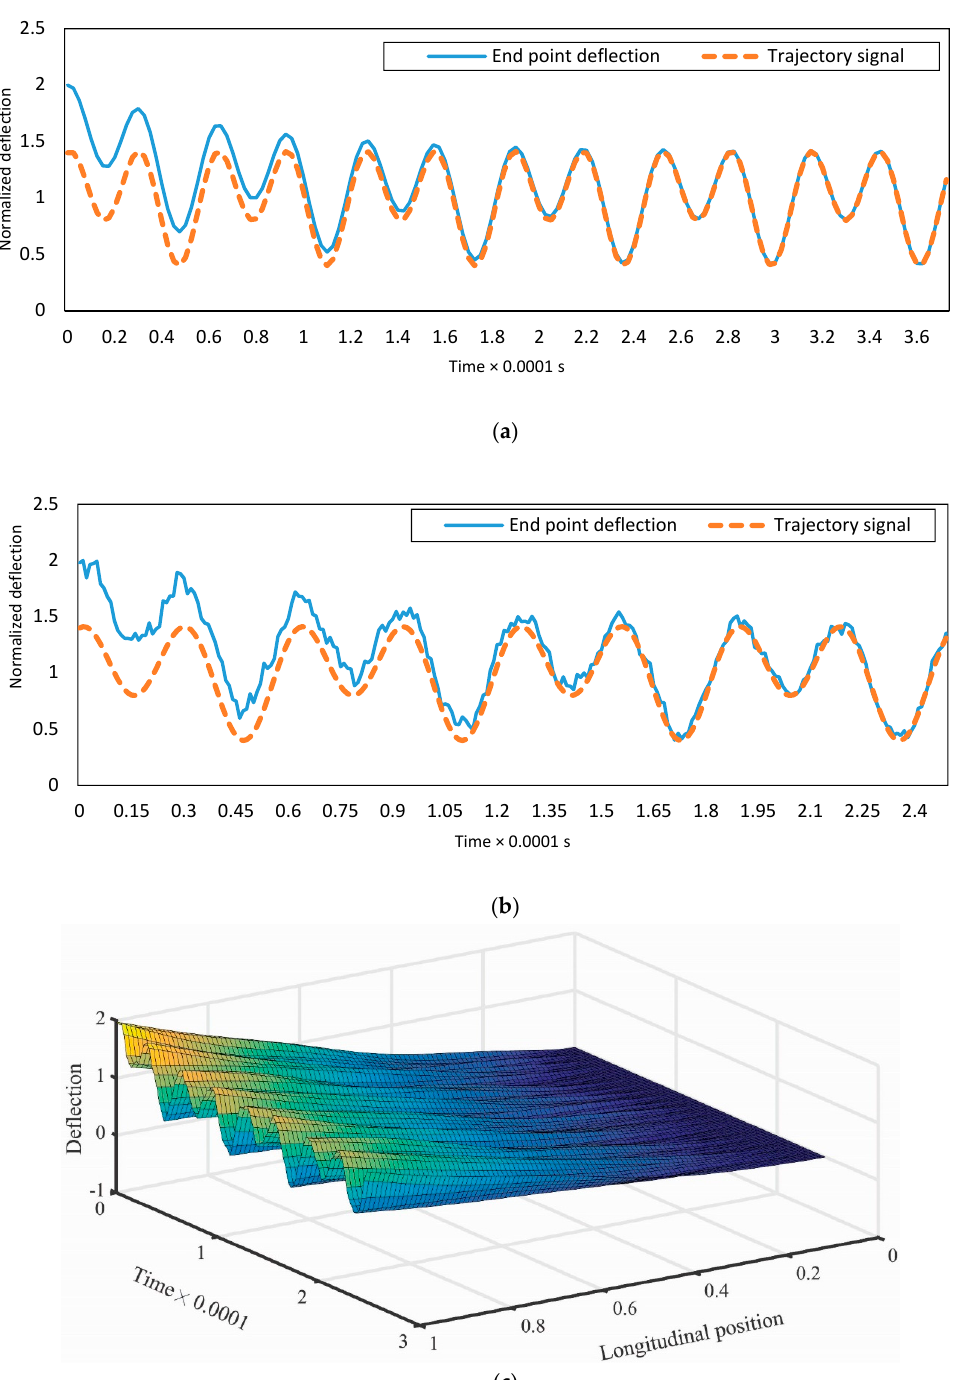
Figure 7. ( a ) Tip deflection of the clamped-free micro-switch for using the first mode; ( b ) tip deflection of the clamped-free micro-switch for using the first five modes; and ( c ) the deflection of the clamped-free micro-switch.